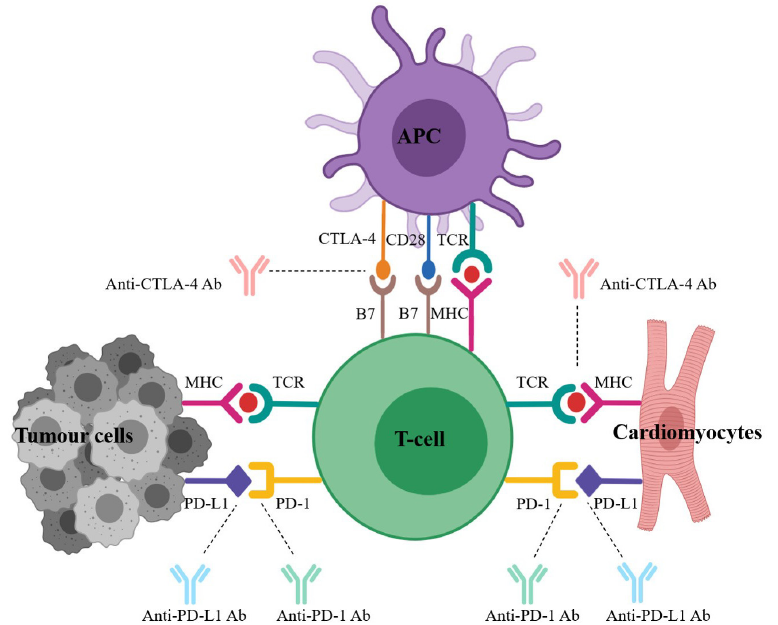
Figure 2. Tumor cells facilitate checkpoint activation to evade immune surveillance.